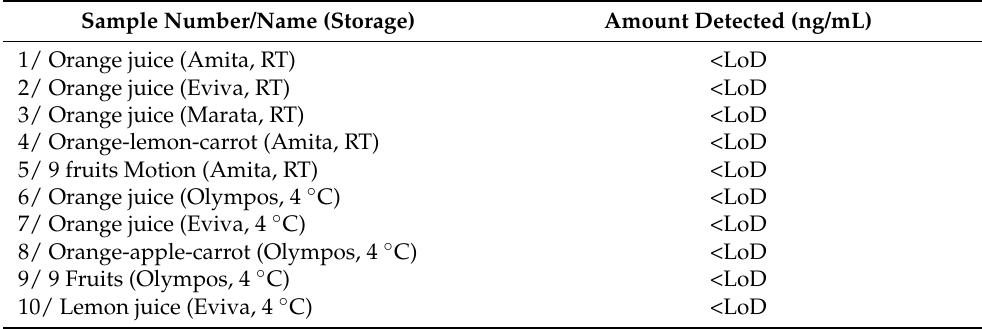
Table 2. Carbendazim residues in commercially available fruit juices. In the parentheses the trade name and storage conditions recommended by the manufacturers are